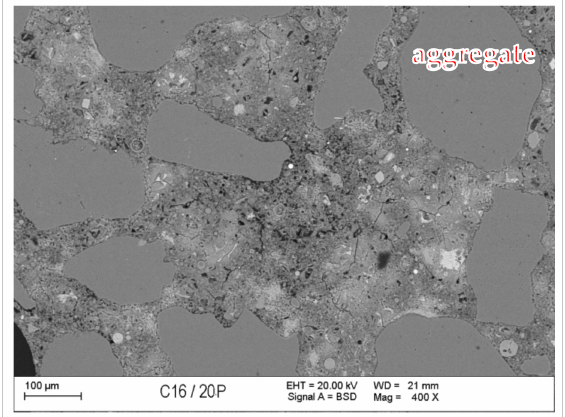
Figure 10. Back-scattered electrons (BSE) image of concrete with fly ash (FA).